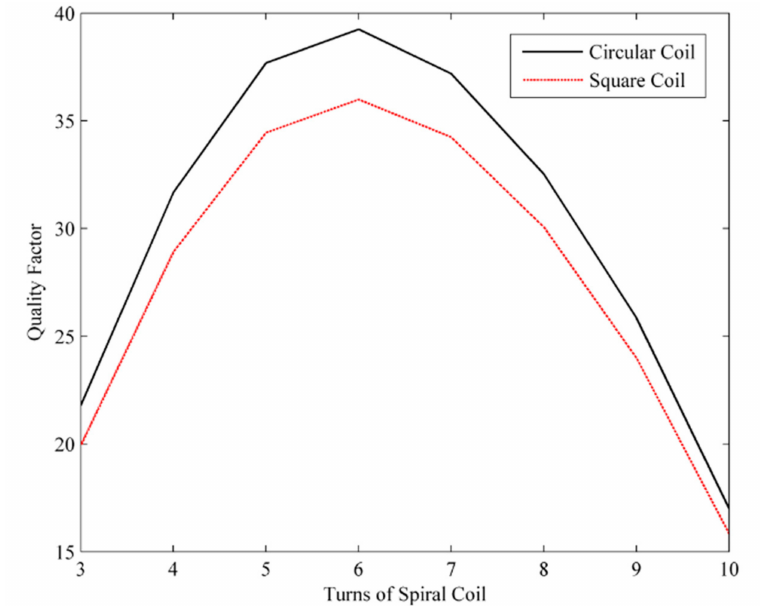
Figure 3. Unloaded Q factor versus the turns of spiral coil for a coil design that has 138 mm external diameter, 53 mm inner diameter, and is printed with a conductive paste which has 24 m Ω / (cid:3) sheet